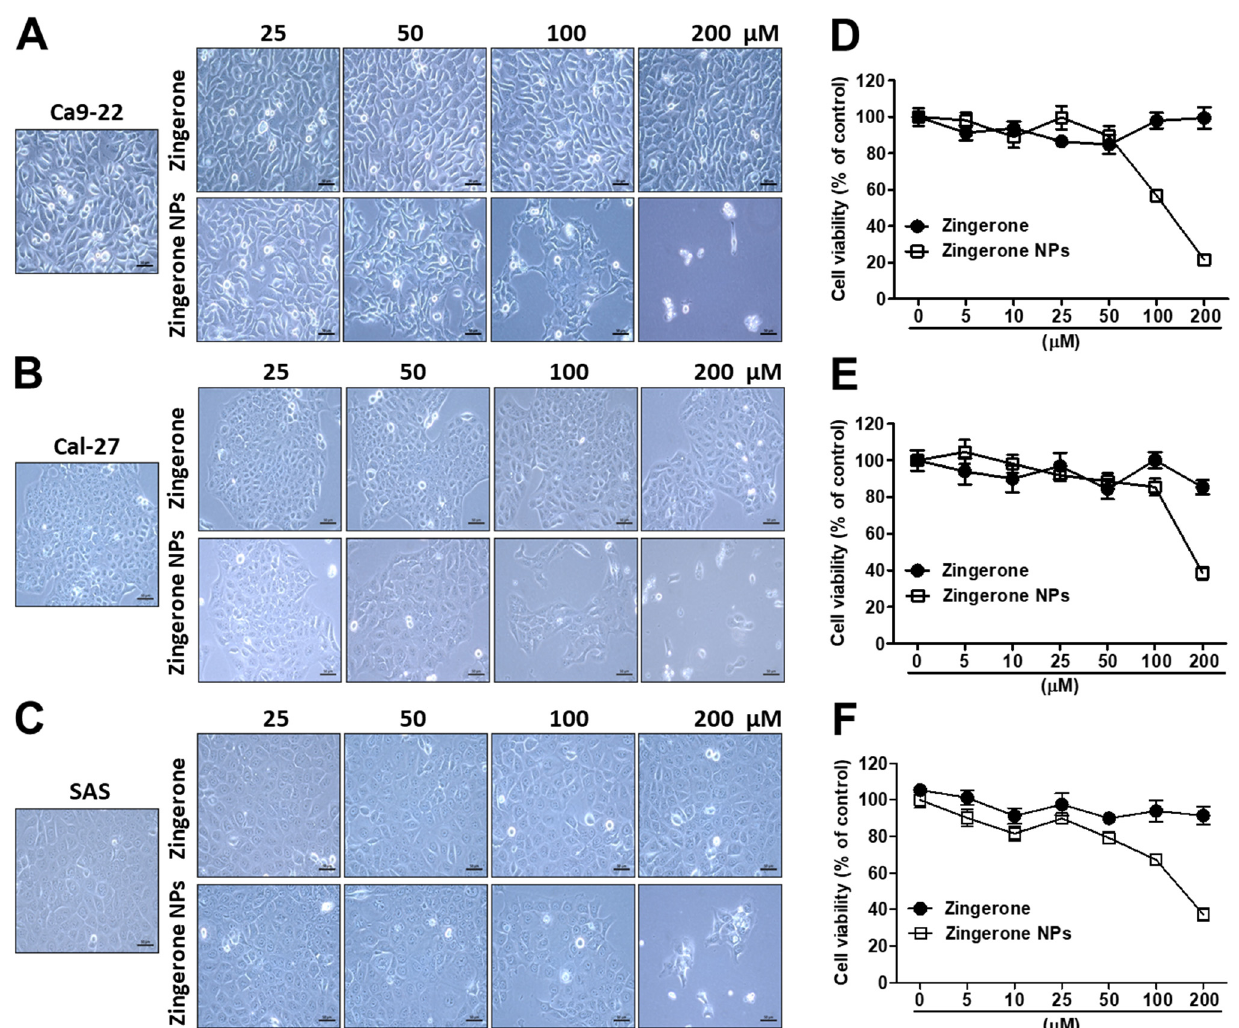
Figure 1. Zingerone NPs induced a significant cytotoxicity in three human OSCC Ca9-22, Cal-27 and SAS cell lines. Cells were treated with zingerone and/or zingerone NPs for 24 h. The effects of zingerone and/or zingerone NPs on cellular morphology and cell viability were observed in Ca9-22 cells ( A ), Ca1-27 cells ( B ), and SAS cells ( C ), respectively, using inverted microscopy. Bar: 50 µm. Further cellular viability was analyzed and recorded using an MTT assay in Ca9-22 cells ( D ), Ca1-27 cells ( E ), and SAS cells ( F ), respectively. Data are expressed as mean ± SEM of three experiments.